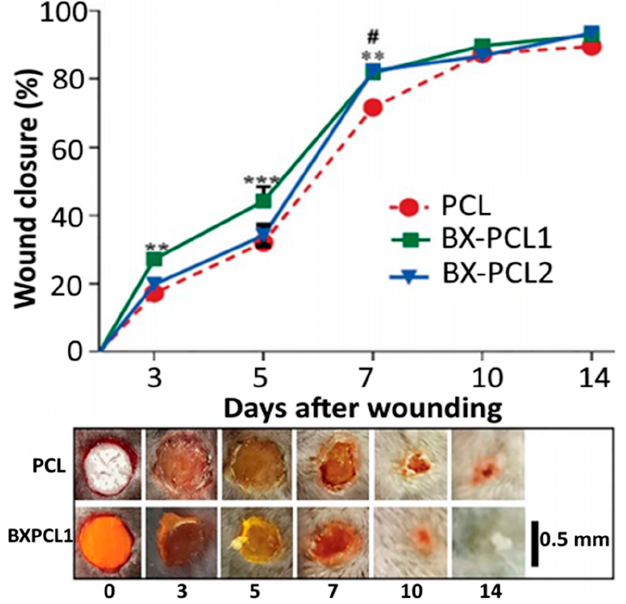
Figure 10. Diabetic wound healing property of bixin-polycaprolactone nanofibers in terms of their wound closure percentage in an excisional skin injury on diabetic mice as a function of time and nanoencapsulated bixin level (2.5 and 12.5% bixin as BX-PCL1 and BX-PCL2) along with their scanning electron microscopic image as well as macroscopic pictures of wound closure. The re- sults were expressed as mean ± standard deviation of ≥ 3 independent replicates and error bars represent the standard deviation from mean values, while **, *** and # symbols represent signifi- cantly different values. BX = bixin and PCL = polycaprolactone. Adapted with permission from Pinzón-García, et al. [102].